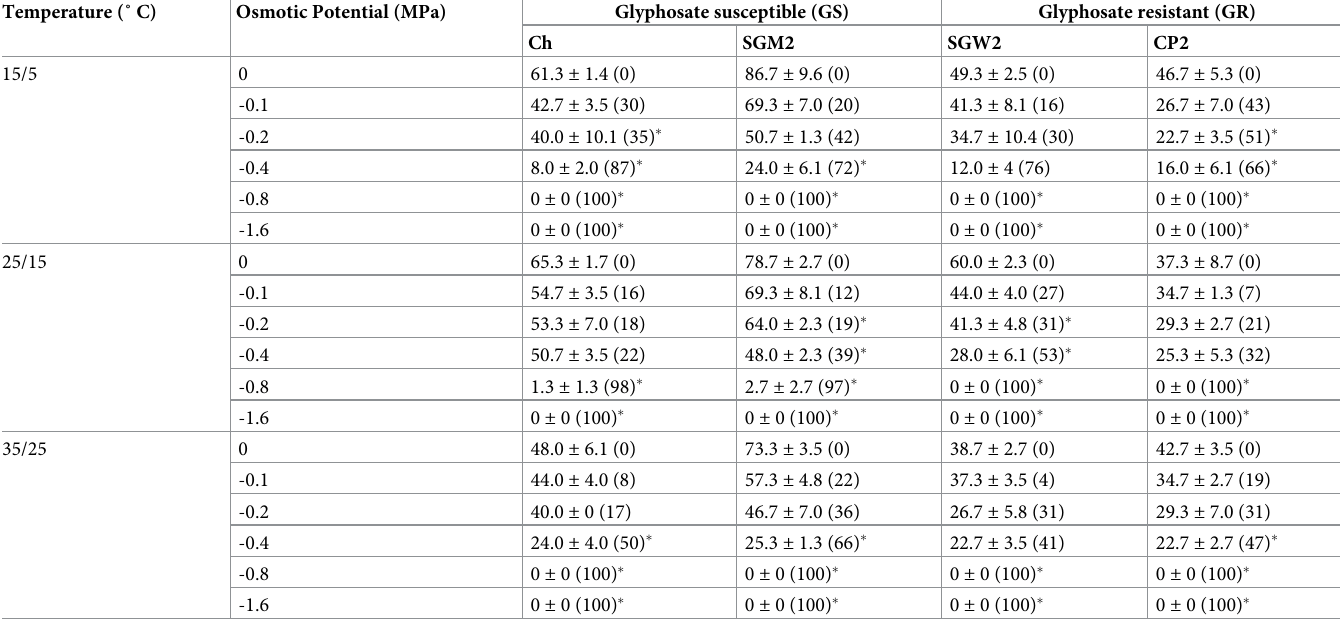
Values after ± and in parentheses are standard errors of means and % reduction of germination to control treatment, respectively. Asterisks denote a significant difference of individual treatment compared to control according to Fisher‘s LSD test at a 0.05% probability level.